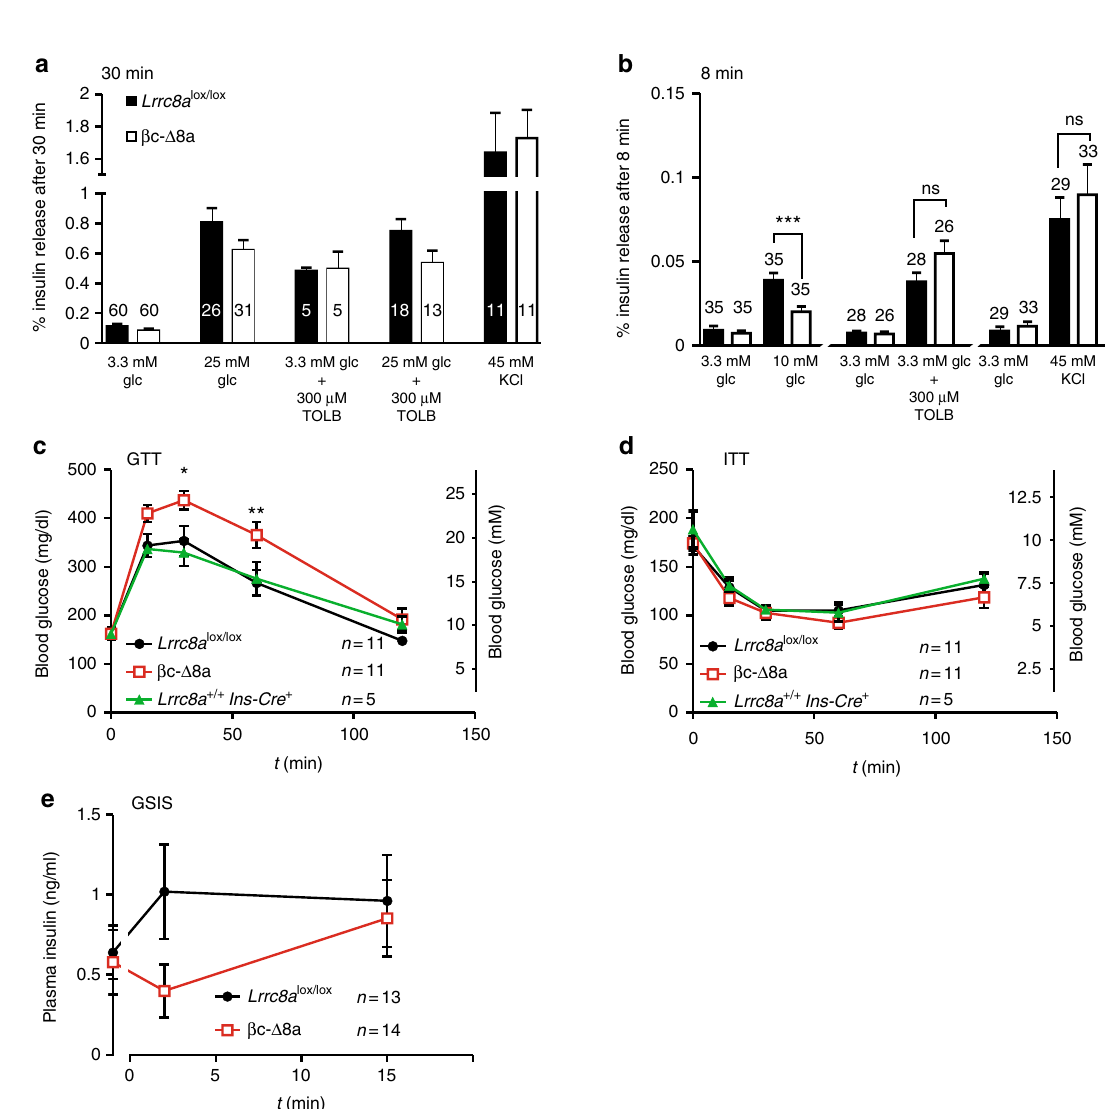
Fig. 6 Effect of LRRC8A/VRAC disruption on insulin secretion in vitro and in vivo and on glucose tolerance. a Insulin release from single islets stimulated by high glucose, tolbutamide, and potassium. Islets were incubated for 30 min under the indicated conditions and insulin concentrations in the supernatant were measured. Number of islets is indicated in bars (derived from 5 mice per genotype (25 mM glc), 1 mouse per genotype (TOLB), 3 mice per genotype (KCl), 2 mice per genotype (TOLB + glc)). b Insulin release of single islets under the indicated conditions during the fi rst 8 min of incubation. Number of islets (from three mice per genotype and condition) is indicated in bars. *** p < 0.001 (one-way ANOVA, Tukey ’ s test). c Glucose tolerance test. Changes in blood glucose levels following intraperitoneal injection of glucose (2 mg/g body weight) in Lrrc8a lox/lox , Lrrc8a + / + ;Ins-Cre + and β c- Δ 8a animals was followed over time. d Insulin tolerance test. Changes in blood glucose levels over time following intraperitoneal injection of insulin (0.75 U/kg body weight). c , d Number of mice (male adults, 10 – 15 weeks old) for each experiment is indicated. * p < 0.05, ** p < 0.01 (two-way ANOVA, Bonferroni multiple comparisons); mean values ± SEM. e Glucose-stimulated insulin secretion in vivo. Changes in the plasma insulin concentration after intraperitoneal injection of a glucose load (2 mg/g body weight) over time. Number of mice (adult males and females, 10 – 15 weeks of age) is indicated. Unpaired t -test for insulin levels at 2 min after glucose injection yields p = 0.07